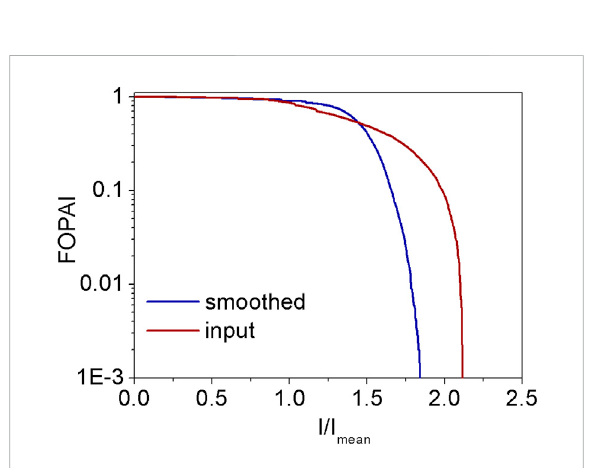
FIGURE 4 Fractionalpoweraboveintensity(FOPAI)comparisonsforthe smoothed beam and the input